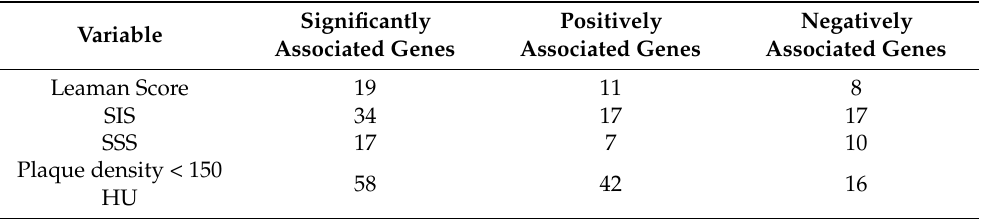
Table 3. Numbers of genes significantly associated with CT plaque features ( p < 0.01 and |R| ≥ 0.6). Significantly Variable Associated